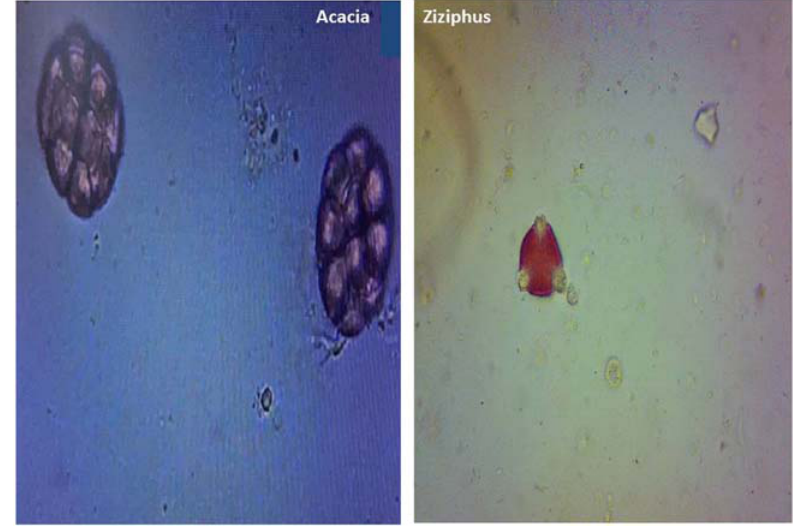
Figure 1: Representative pollens of the studied honey